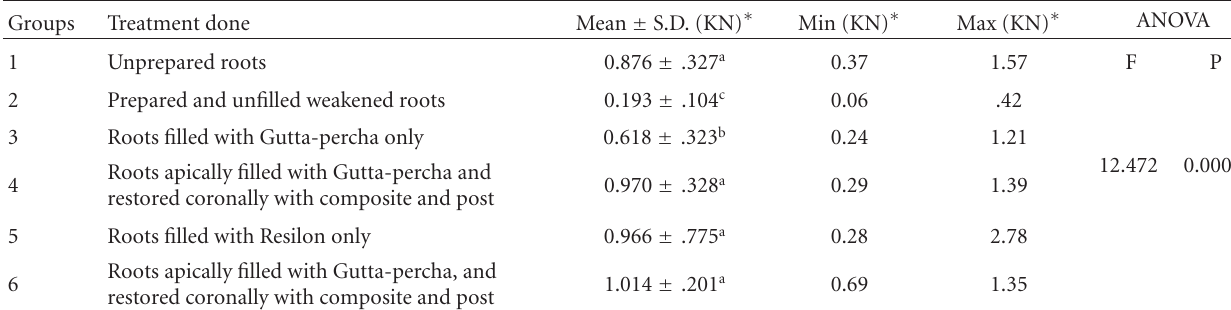
Table 2: Comparison of fracture strengths of all groups.